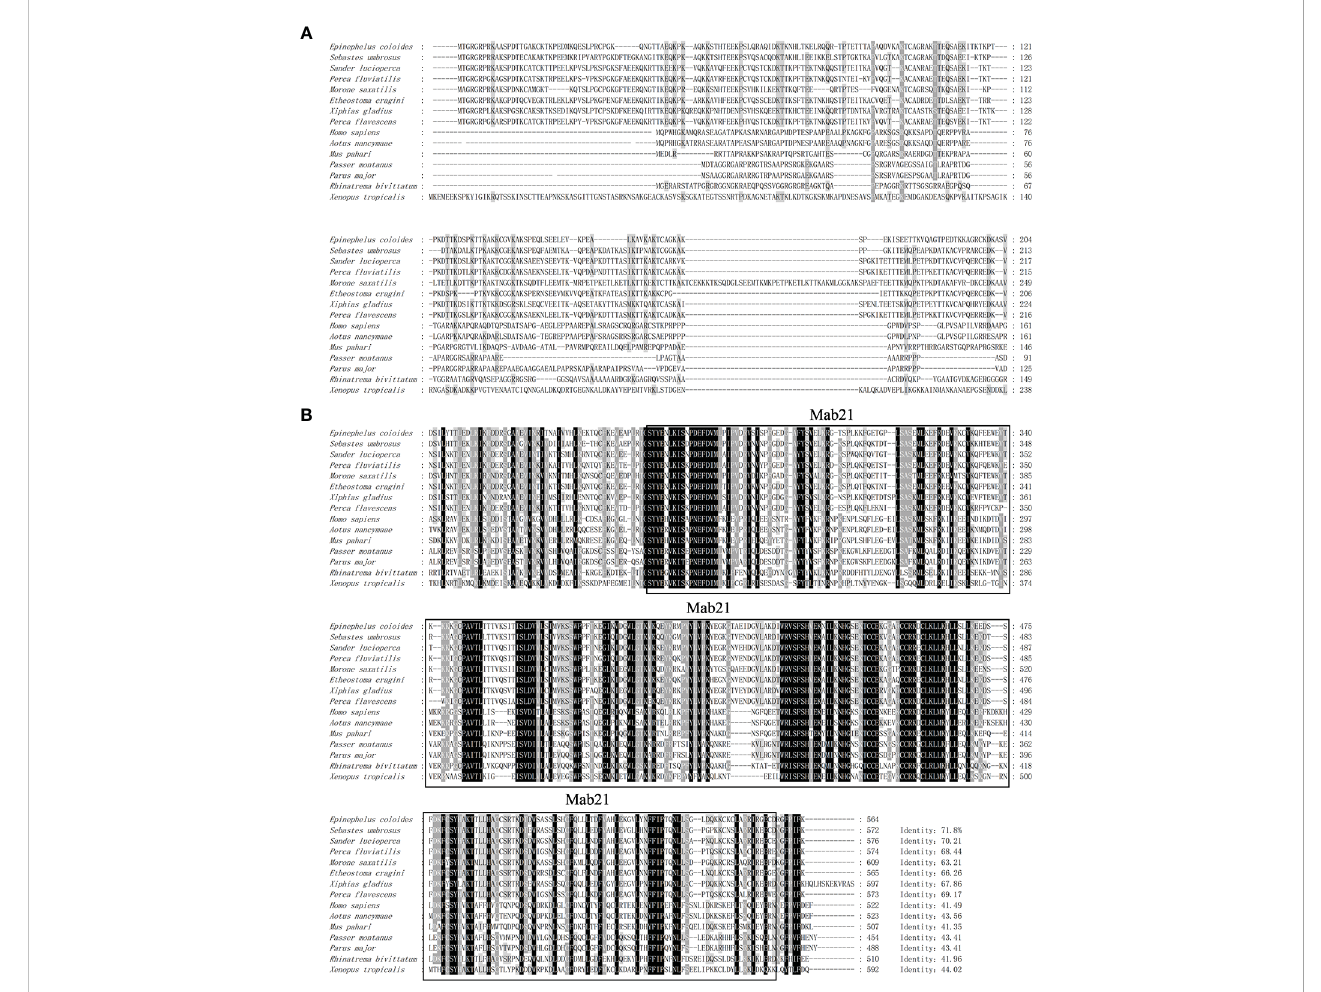
FIGURE 1 Sequence analysis and phylogenetic tree construction of EccGAS. (A) Multiple sequence comparison of the amino acid of EccGAS and cGAS proteins from other organisms. The predicted conserved structural domain of Mab21 is shown. (B) Phylogenetic tree of EccGAS proteins. The numbers on the nodes indicate bootstrap values for 1000 replicates. Scale bars represent 0.1 change per